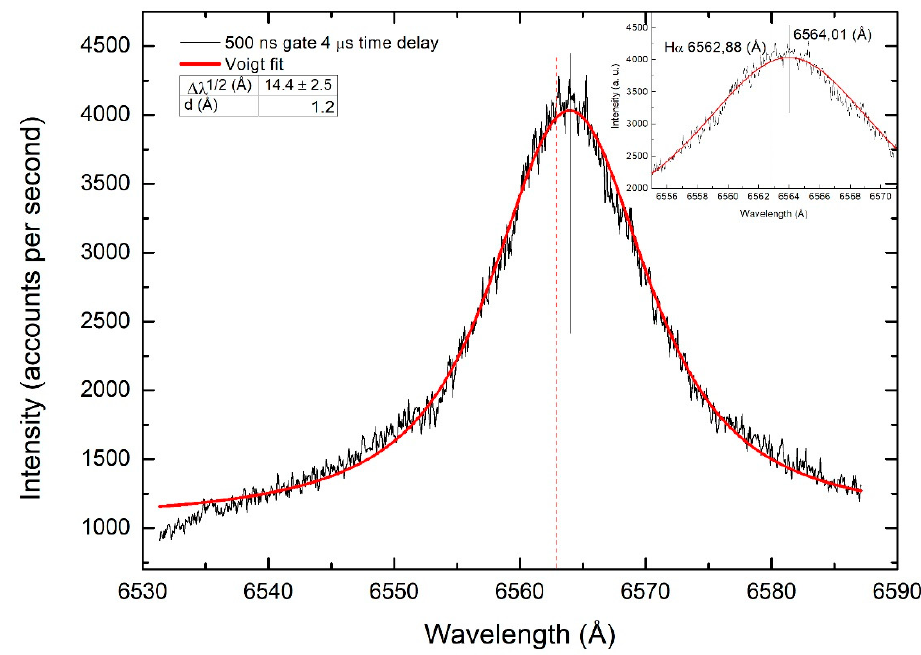
Figure 6. Voigt profile fitting to experimental H α -line emission of the plasma with a gate time of 500 ns at 4 µ s delay time with a wavelength range from 6530 to 6590 Å.